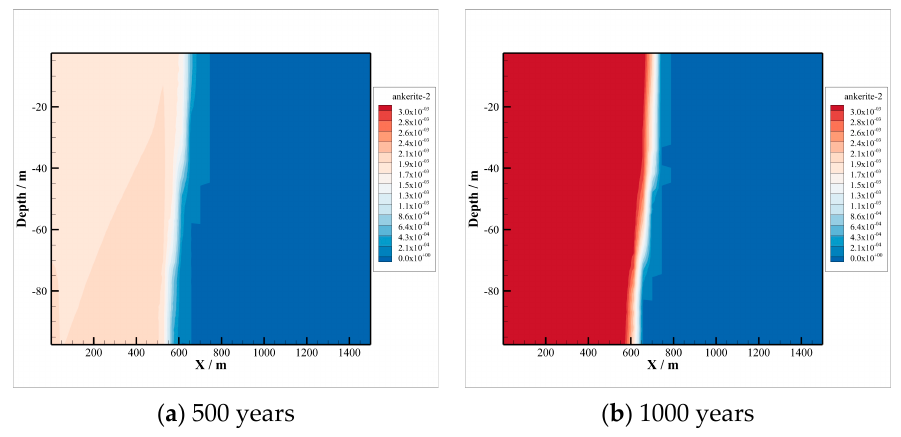
Figure 9. Siderite precipitation.